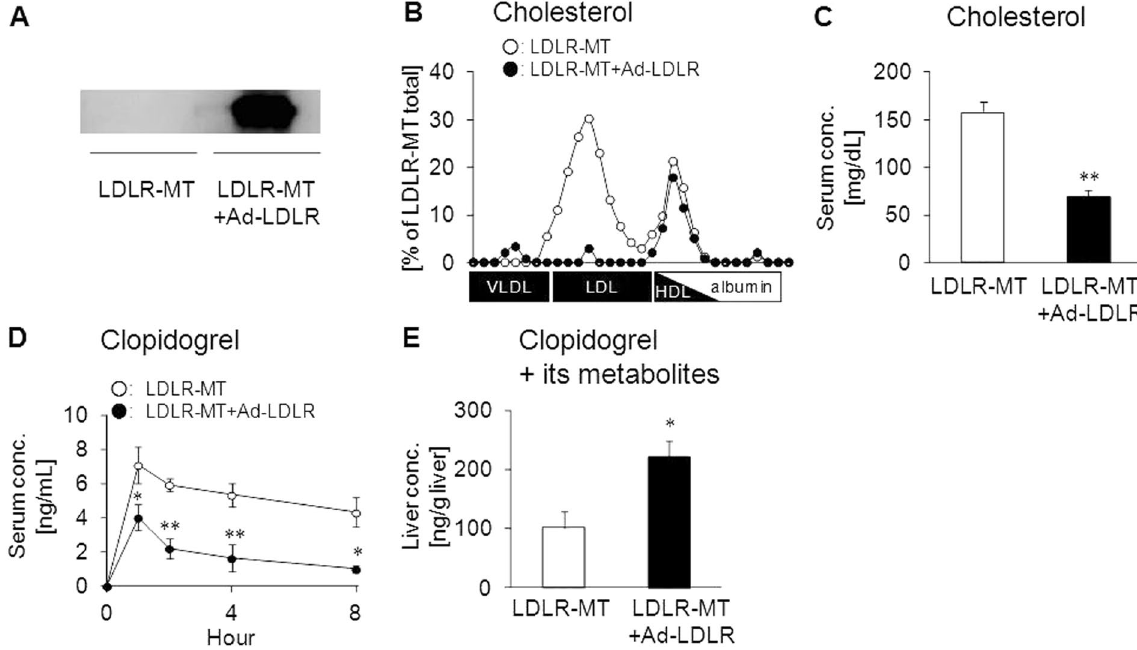
Figure 6. Effect of LDLR overexpression on VLDL/LDL-mediated drug transport in vivo . (A ) LDLR- mutant (LDLR-MT) mice were infected with LDLR-expressing adenovirus to generate LDLR-rescued mice (LDLR-MT + Ad-LDLR). GFP-expressing adenovirus was used as a control. Three days after the infection, overexpression of LDLR was confirmed by western blotting. (B) Association of cholesterol with lipoproteins in LDLR-MT and LDLR-MT + Ad-LDLR mice. (C) Effect of adenovirus-mediated LDLR-overexpression (Ad-LDLR) on serum cholesterol concentration in LDLR-MT mice. (D) Serum clopidogrel concentration in LDLR-MT and LDLR-MT + Ad-LDLR mice. (E) Effect of LDLR rescue on the hepatic concentration of clopidogrel and its metabolites at 4 h after clopidogrel administration. Bars represent the mean ± s.e.m. * p < 0.05, ** p <